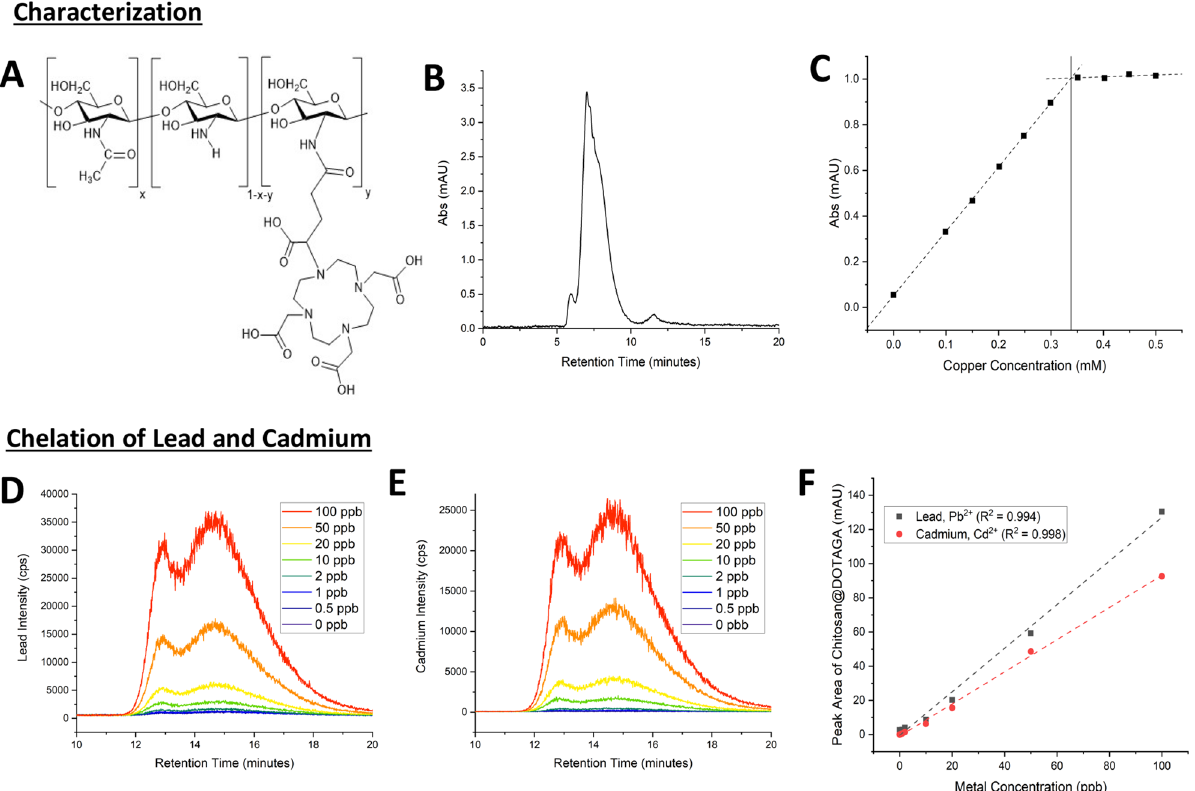
Figure 1. ( A ) Representation of re-acetylated chitosan functionalized by DOTAGA. Chitosan@DOTAGA where x corresponds to the acetylation ratio and y corresponds to the DOTAGA grafted ratio. ( B ) SEC HPLC-UC elution diagram of 10 g L −1 Chitosan@DOTAGA in aqueous medium in absence of Cu(II) using detection at 295 nm. The peak at 7 min corresponds to the Chitosan@DOTAGA polymer, while the smaller peak at 11 min corresponds to residual, un-grafted DOTAGA. ( C ) Dosage of a solution of 1 g L −1 of Chitosan@ DOTAGA by Cu(II) using SEC HPLC–UV. The integration of the polymer peak at 7 min was performed for each added concentration of copper providing a linear relationship until saturation of all available DOTAGA. (D) SEC HPLC–MS of 0.1 g L −1 of Chitosan@DOTAGA in the presence of varying Pb(II) concentrations. ( E ) SEC HPLC–MS of 0.1 g L −1 of Chitosan@DOTAGA in the presence of varying Cd(II) concentrations. This method of analysis employs a slower flow rate (0.4 mL min −1 compared to 0.8 mL min −1 ) than the previous, providing a longer Chitosan@DOTAGA retention time of 14.6 min, which is in agreement with the previous retention time of 7 min. Both peaks visualized in this method are representative of the same species, Chitosan@ DOTAGA. Lead and cadmium chelation by Chitosan@DOTAGA follows a similar trend. ( F ) Dosage of a solution of 0.1 g L −1 of Chitosan@DOTAGA by Pb(II) and Cd(II) using detection of isotopic masses. The integration of the polymer peaks in ( D ) and ( E ) were performed for each metal concentration providing a linear relationship. A slight preference of chelation can be seen for lead, which is in agreement with the complexation